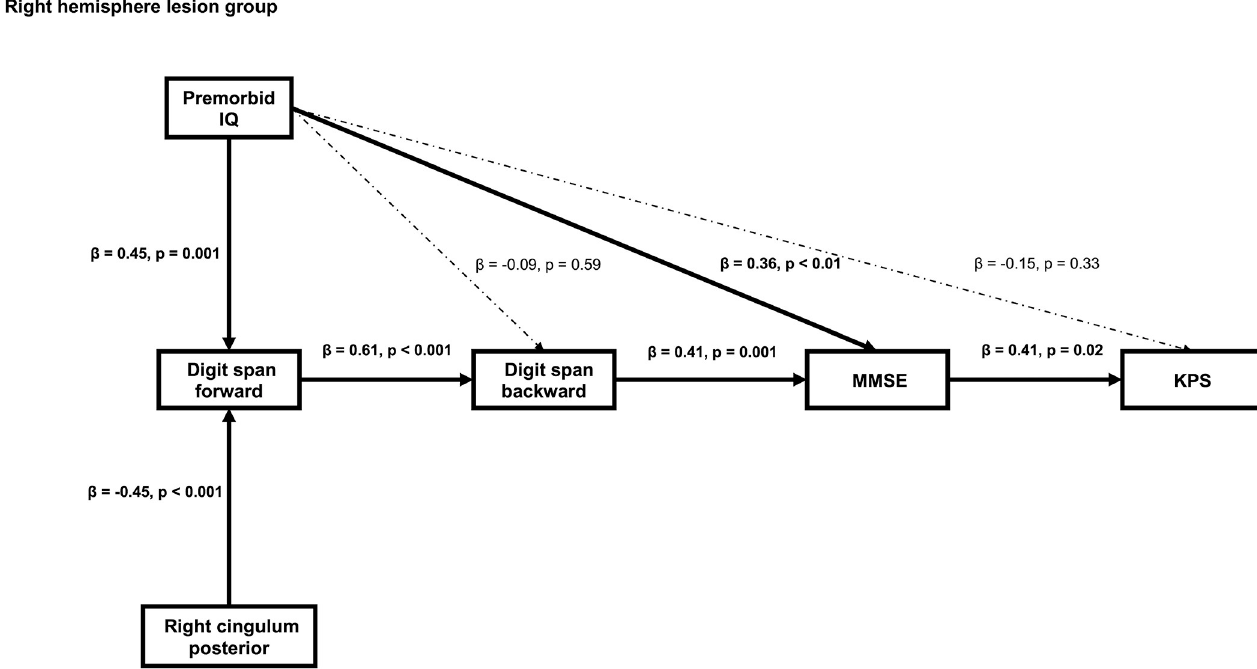
Fig 3. Path analysis of patients in the right hemisphere lesion group. The result of the path analysis shows a positive effect on premorbid IQ and a negative effect on damage to the right cingulum posterior part of the postoperative digit span forward. Premorbid IQ directly affects postoperative MMSE scores. Premorbid IQ and damage to the right cingulum posterior partly influence the KPS by mediating the digit span forward, digit span backward, and MMSE. Note: Right cingulum posterior: disconnection ratio of the right cingulum posterior part; MMSE, Mini-Mental State Examination; KPS, Karnofsky Performance Status; solid line, statistically significant; dotted line, not statistically significant. We omitted the influence of the age on the digit span (forward and backward), MMSE, and KPS.